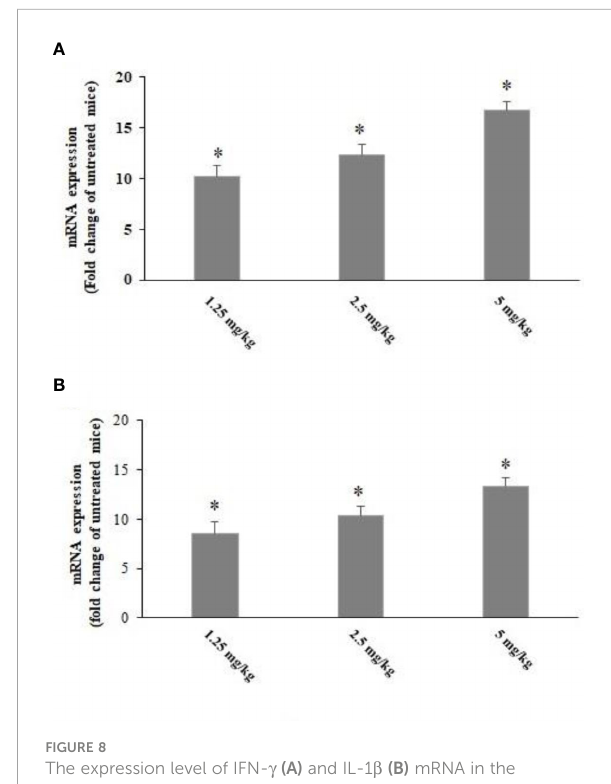
FIGURE 7 The level of IFN- g and IL-1 b in the Toxoplasma gondii -infected mice pre-treated with Curcuma longa essential oil (CLE) at the doses of 1.25, 2.5, and 5 mg·kg − 1 ·day − 1 in comparison with the control group. Data are expressed as the mean ± SD. *p < 0.05 (n = 6).